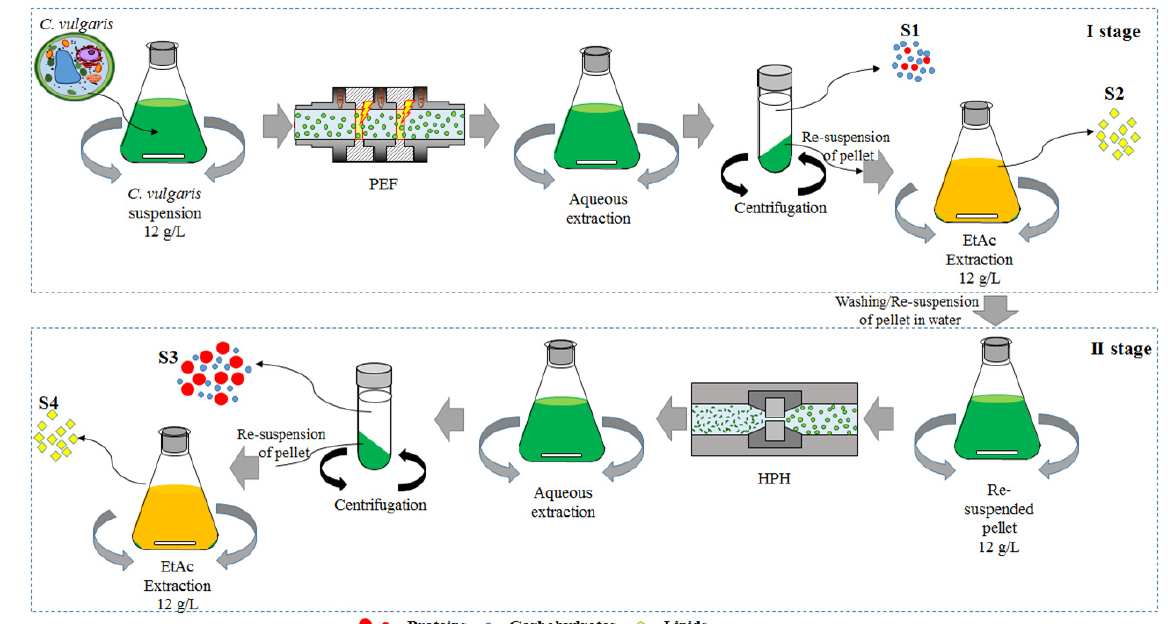
Figure 1. Schematic representation of the “cascade biorefinery” of C. vulgaris microalgae proposed in this study. I stage: PEF-assisted extraction; II stage: HPH-assisted extraction. EtAc: ethyl acetate.